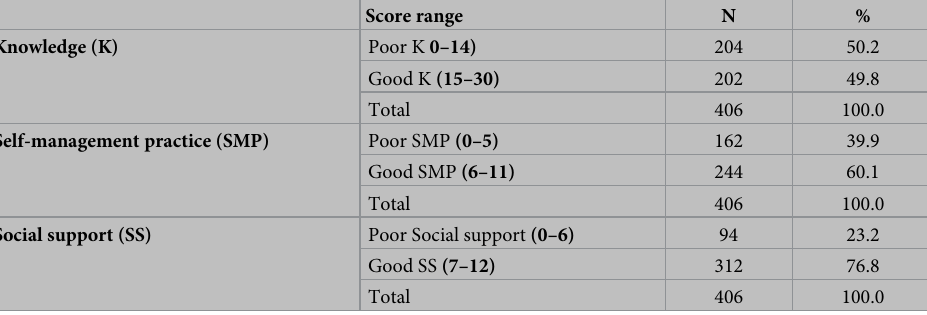
Table 2. Knowledge, diabetes self-management practices, social support